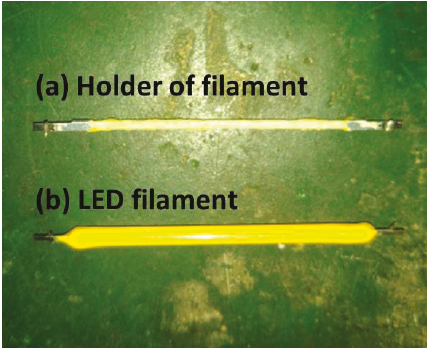
Figure 2: (a) Holder of the fi lament and (b) LED fi lament in the A60